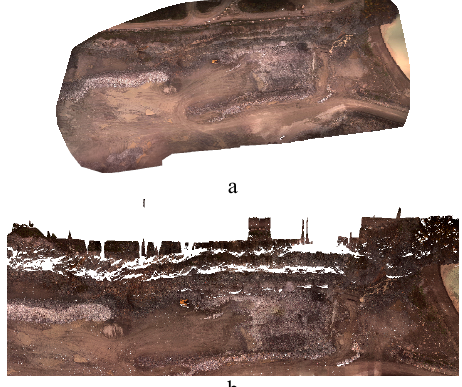
Figure 7. Visualization of the preliminary 3D products from